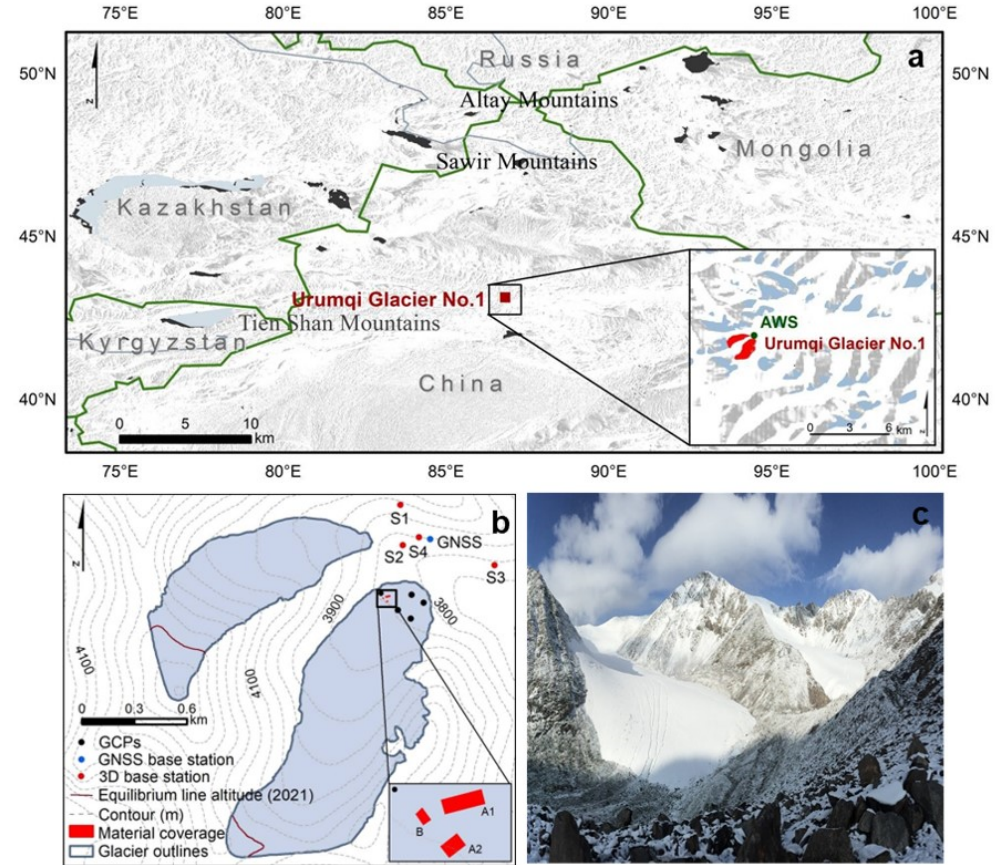
Figure 1. ( a ) Location of UG1 and Tien Shan. ( b ) The extent of the monitored area with artificial melt reduction in UG1. ( c ) Overview of the glacier tongue.